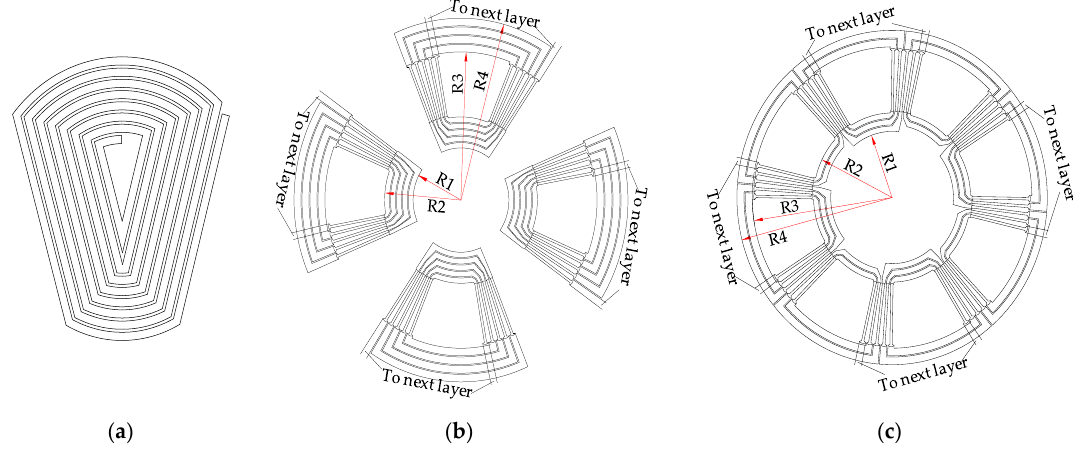
Figure 3. Schematic diagram of three different stator windings of one phase: ( a ) spiral winding; ( b ) distributed winding; ( c ) improved winding. ( b ) distributed winding; ( c ) improved